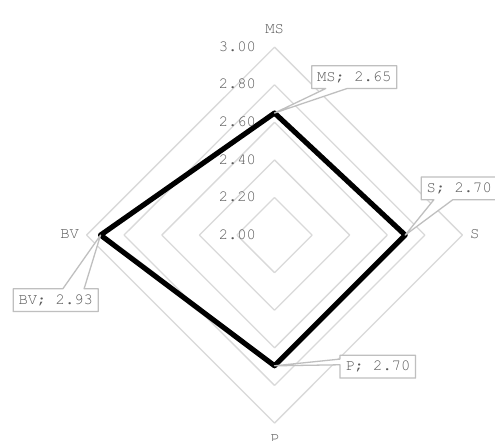
Fig. 1 – The impact of design on company variables - Spider chart. Source: own research